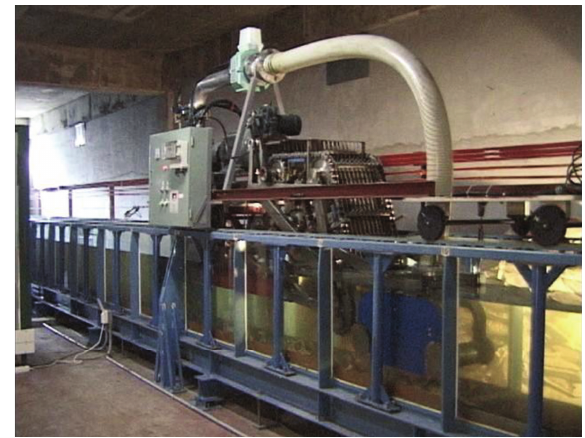
Figure 3: Test bed of hybrid type collector in 2-D